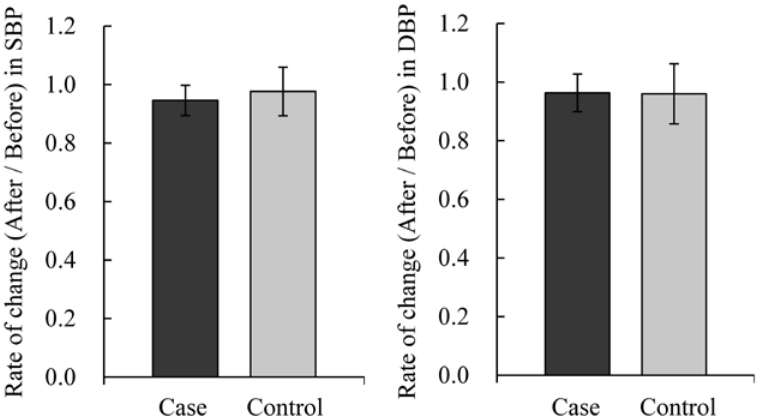
Figure 6. High frequency (HF) component and low-to-high frequency (LF/HF) component ratio.